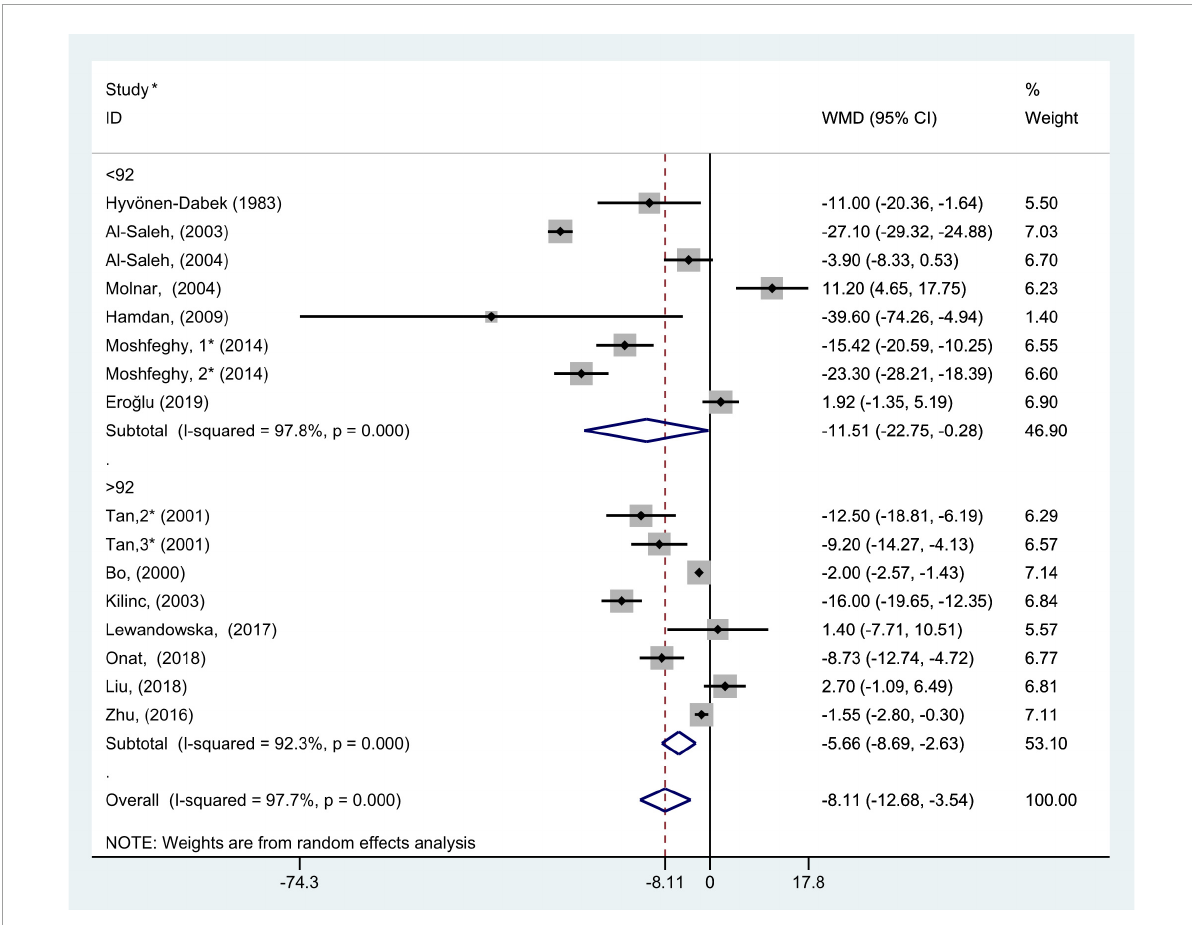
FIGURE10 Subgroup analysis of blood selenium level in patients with gestational diabetes mellitus and healthy pregnant women based on sample size. The random effect model is applied. For studies in which blood selenium levels were measured during different pregnancy periods in one study, 1, 2, and 3 are used to denote measurements performed in the first, second, and third trimesters, respectively. *First author (year of study